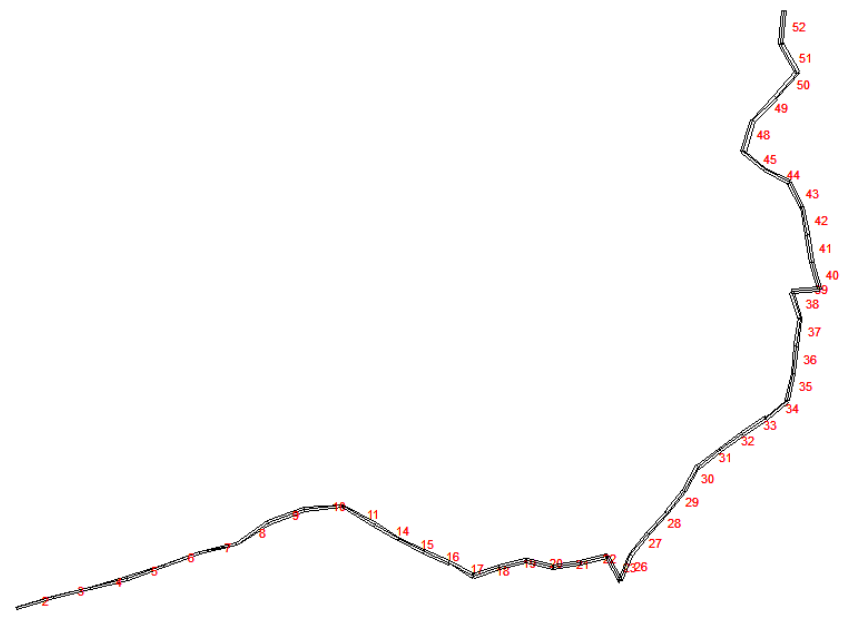
Figure 11. W2 computation grid plan view for the mainstem Xiaxi River.